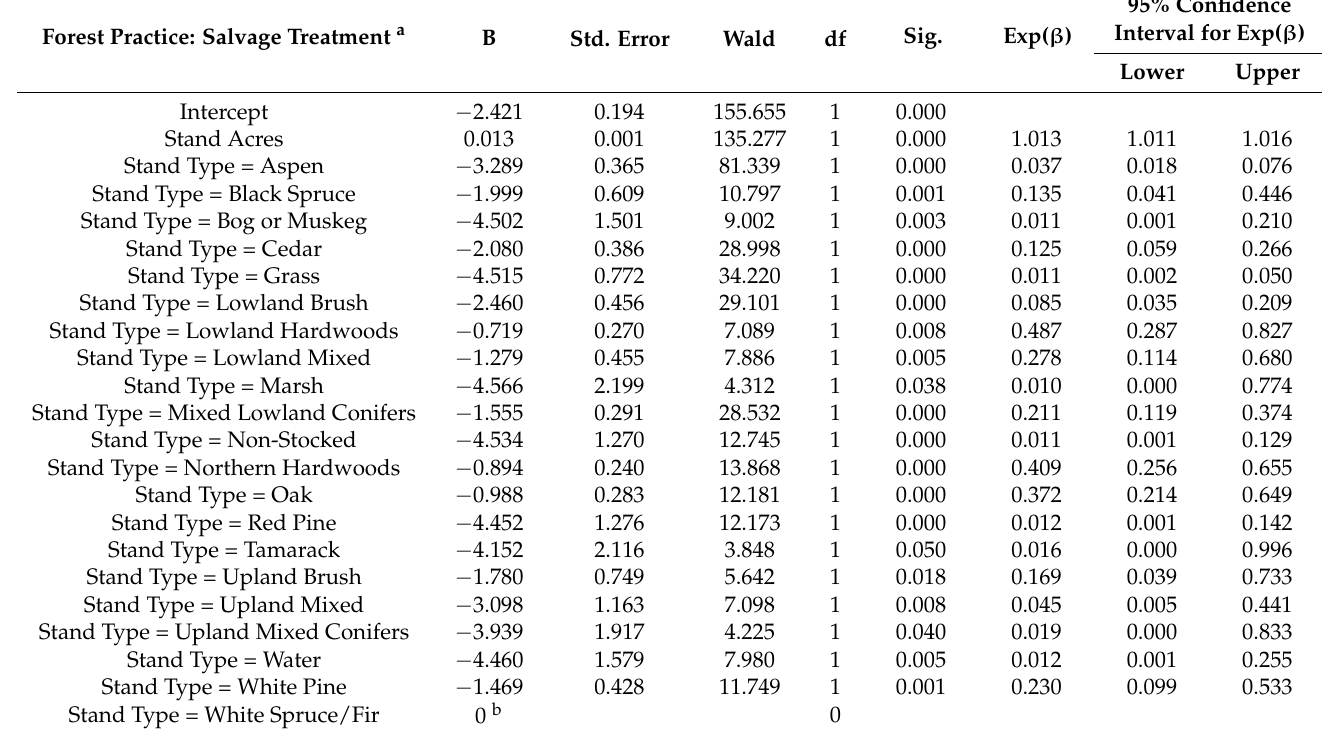
Table 4. Multinomial logistic regression parameter estimates for significant results predicting the forest practice “Salvage Treatment.” Stand acres and stand type as independent variables (showing results from salvage treatment). N = 20,915